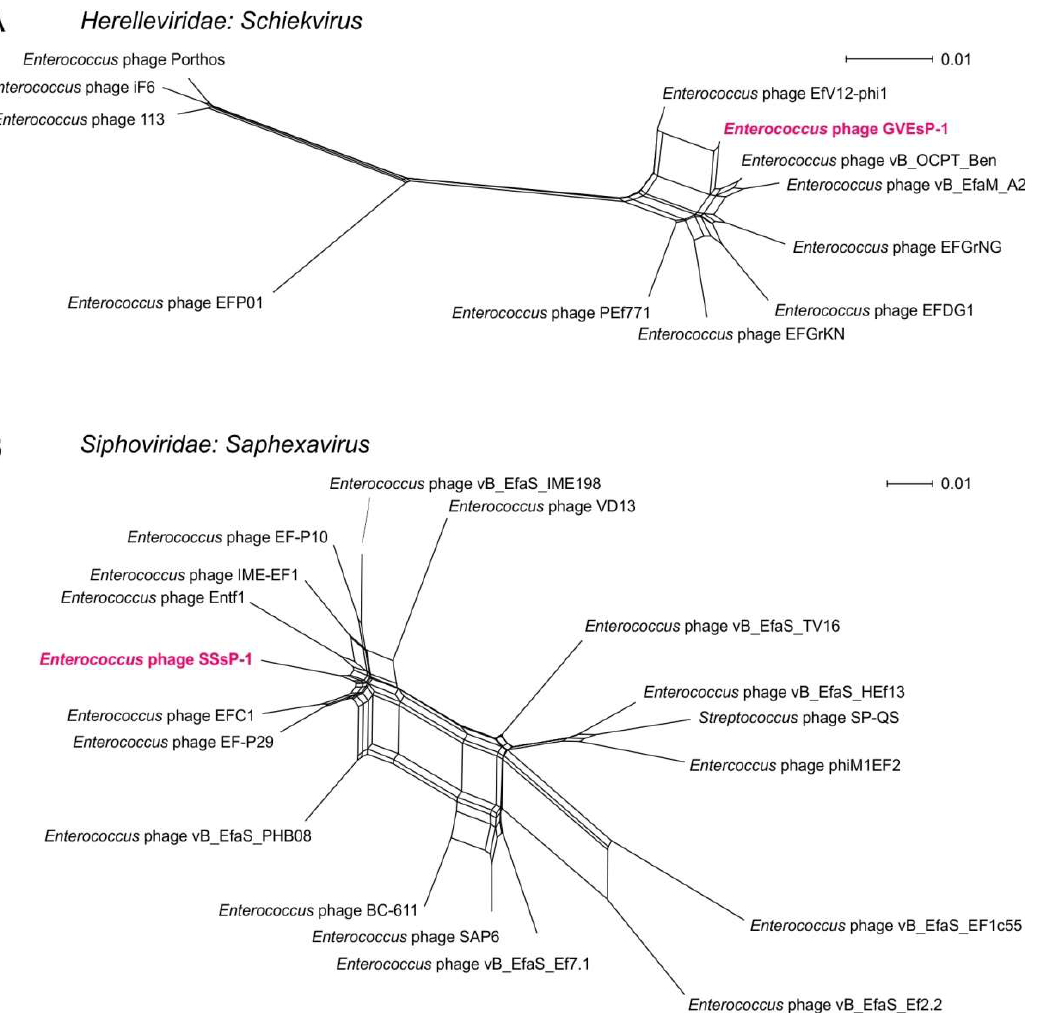
Figure 4. Evolutionary relationships of studied bacteriophages within Schiekvirus and Saphexavirus visualized by NeighborNet phylogenetic networks. ( A ) The position of GVEsP-1 within Schiekvirus . ( B ) The position of SSsP-1 within Saphexavirus . The viruses described in the present work are highlighted in purple.